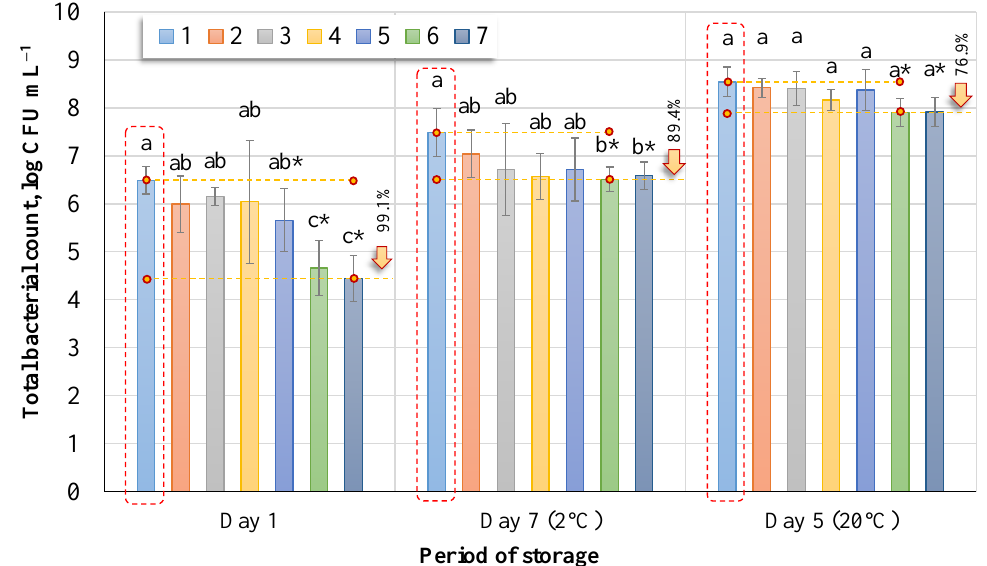
Figure 3. Changes in the total bacterial count in birch sap: 1 (control)—not ozonated sap (initial); 2—sap ozonated for 5 min; 3—sap ozonated for 10 min; 4—sap ozonated for 15 min; 5—sap ozonated for 20 min; 6—sap ozonated for 25 min; 7—sap ozonated for 30 min. Significant, substantial differences are distinguished by different letters (Tukey HSD test). Single letters indicate that there is no significant difference. Differences were considered significant when the p values were less than 0.05 ( n = 18). In the Dunnett test, significant differences between the control group (No. 1) and the treatment group are marked with an asterisk “*”.